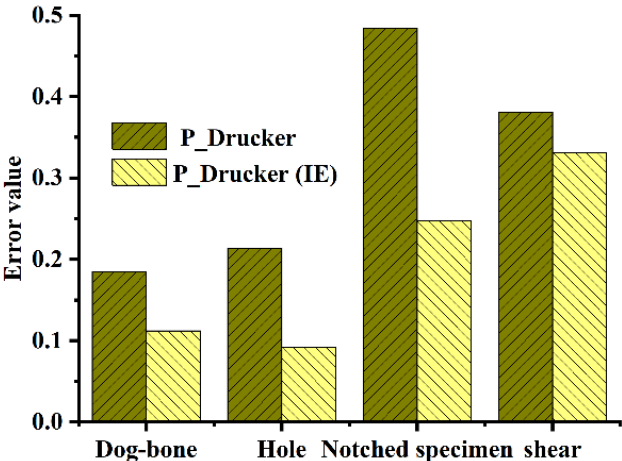
Figure 11. Comparison of the prediction error value before and after parameter optimization.